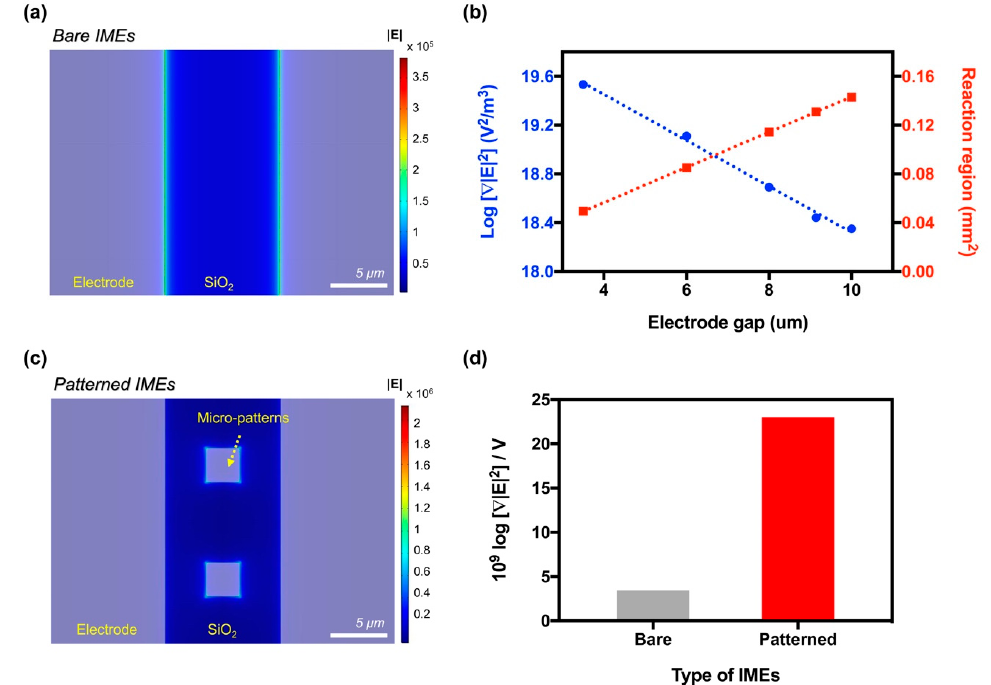
Figure 2. Enhancement of the electric field by the micropattern between the IMEs. ( a ) Intensity of the electric field on the surface of the bare IMEs when 0.5 V was applied, ( b ) intensity of the 𝛁|𝑬 𝟐 | and the reaction region corresponding to the gap between the electrodes in the bare IMEs, ( c ) intensity of the electric field on the surface of the patterned IMEs when 0.5 V was applied, and ( d ) the value of the 𝛁|𝑬 𝟐 | per voltage in the bare IMEs (gap: 10 μ m) and in the patterned IMEs. The values were calculated through a power series fitting of the dots (y = Ax B + Cx D ) with 95% confidence.